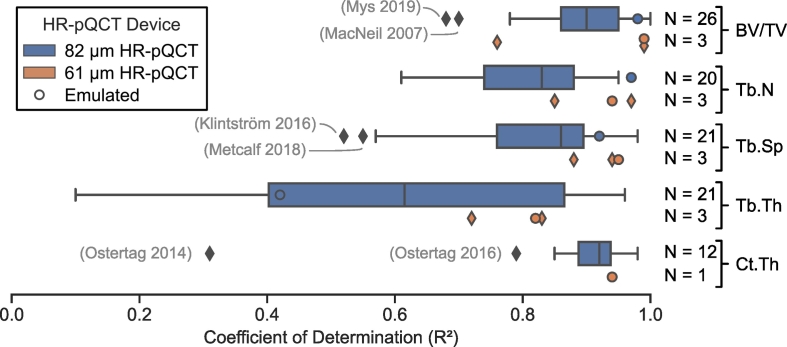
Coefficient of determination for the most commonly reported morphometric parameters, which were reported in more than ten studies: bone volume fraction (BV/TV), trabecular number (Tb.N), trabecular separation (Tb.Sp), trabecular thickness (Tb.Th), and cortical thickness (Ct.Th). Emulated image data, such as 82 μm HR-pQCT data obtained from downsampled micro-CT or 61 μm HR-pQCT devices, is included both in the box plot and additionally highlighted by circles to identify any differences to parameters derived from 61 μm or 82 μm HR-pQCT images using the default manufacturer settings. In general, we observe that BV/TV can be captured well with both HR-pQCT resolutions while results for other parameters, such as Tb.Th, vary drastically across studies for 82 μm images and should be interpreted with caution.